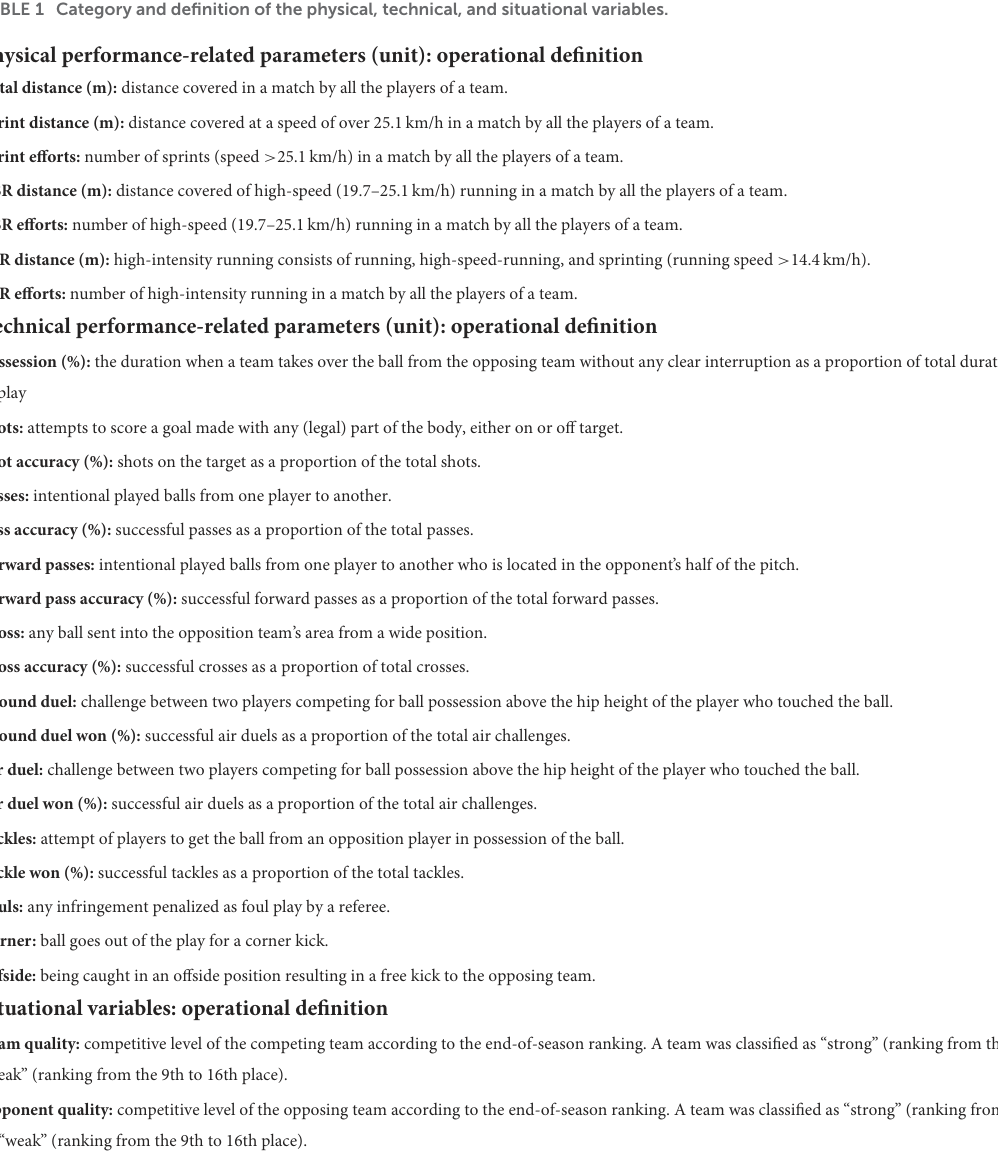
TABLE 1 Category and definition of the physical, technical, and situational variables. Physical performance-related parameters (unit): operational definition Total distance(m): distance covered in a match by all the players of a team.